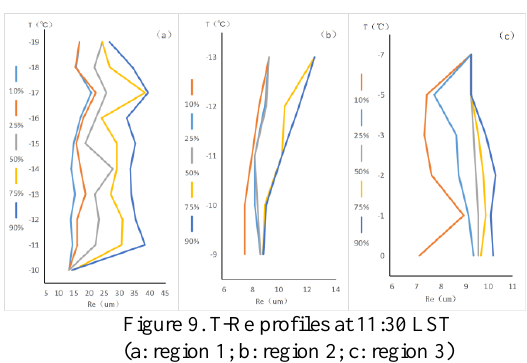
Figure 8. RGB image at 11:30 LST